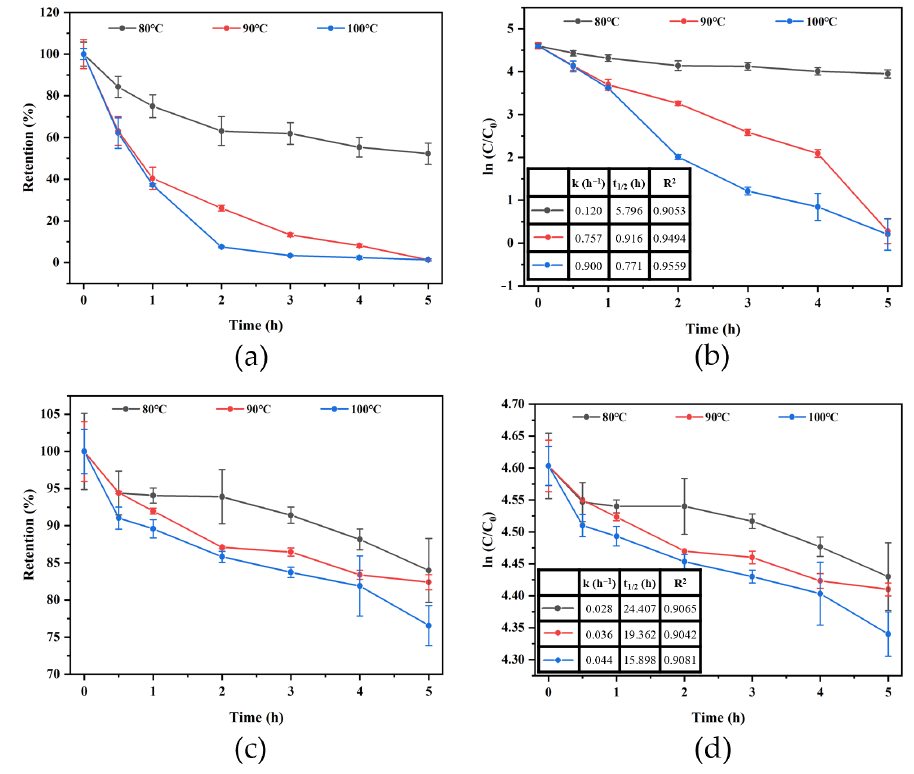
Figure 5. Plots of retention and ln (C/C 0 ) vs. heating time with Glu-Phe ARPs ( a , b ) and the CD-ARP complex ( c , d ) at different temperatures.